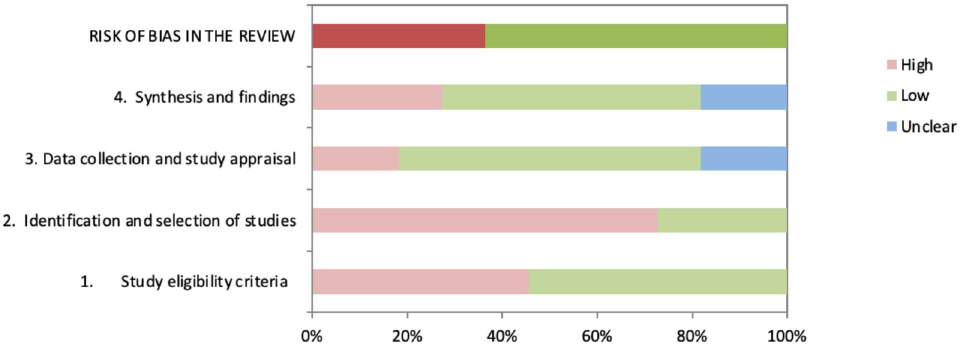
Fig 2. Risk of bias assessment with ROBIS tool. Darker colours indicate overall ROBIS rating; lighter colours concern judgments.